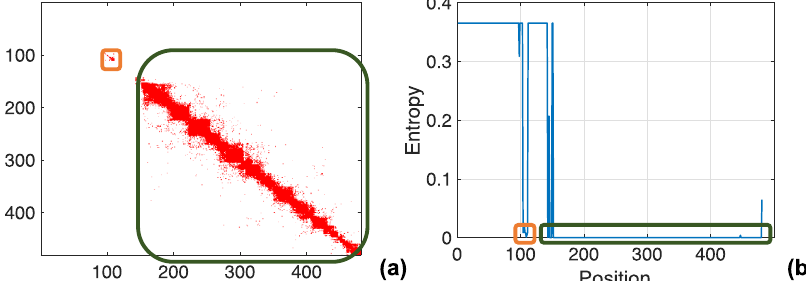
Fig. 9 Conformation maps of replicated human chromosomes. a Visualization of the binarized chromosome 21 Cis sister contacts. X and Y axis are the locations of genomic loci. Topologically associating domains (TADs) are circled with orange and green squares. b Entropy of the soft assignments τ u at each position. Small entropy are marked with orange and green squares in correspondence with the squares in a . We summarize that TADs are in correspondence with low entropy of node attribute